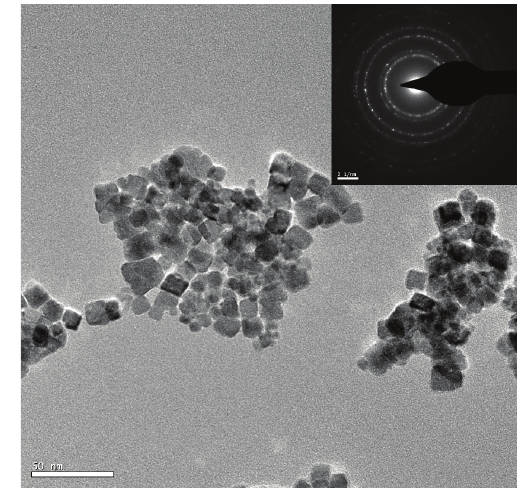
Figure 4: Typical TEM image of as-prepared 10mol% La 2 O 3 doped CeO 2